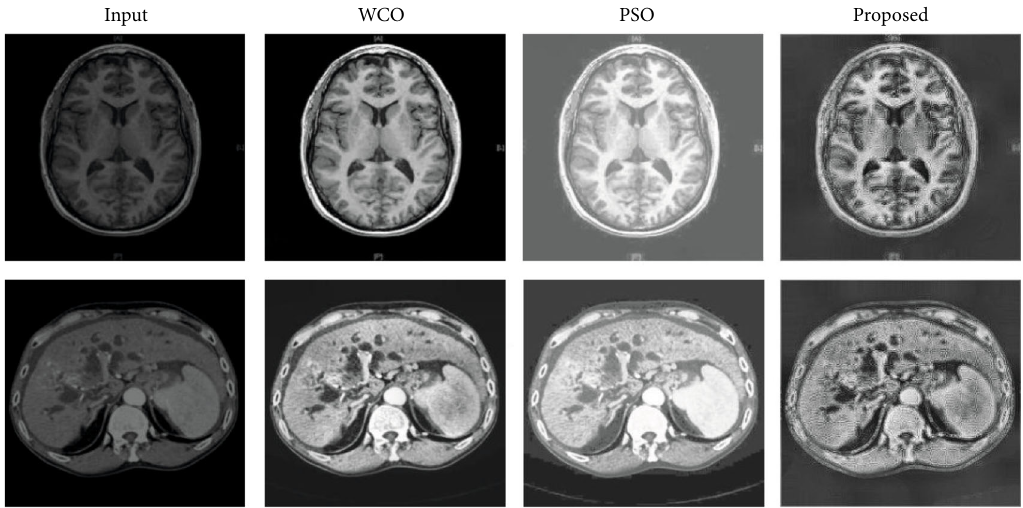
Figure 5: Summary of the example of the test comparison between the original image and the results from the WCO [58], PSO [61], and the proposed